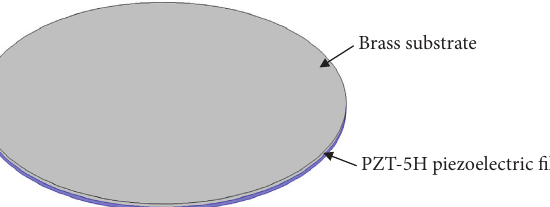
Figure 9: Finite element model of circular piezoelectric plate.